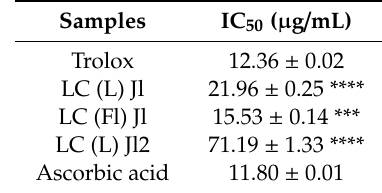
Table 6. IC 50 values of antioxidant activity of L. camara essential oil by 2,2-diphenyl-1-picrylhydrazyl (DPPH) assay. Data are expressed as the mean of